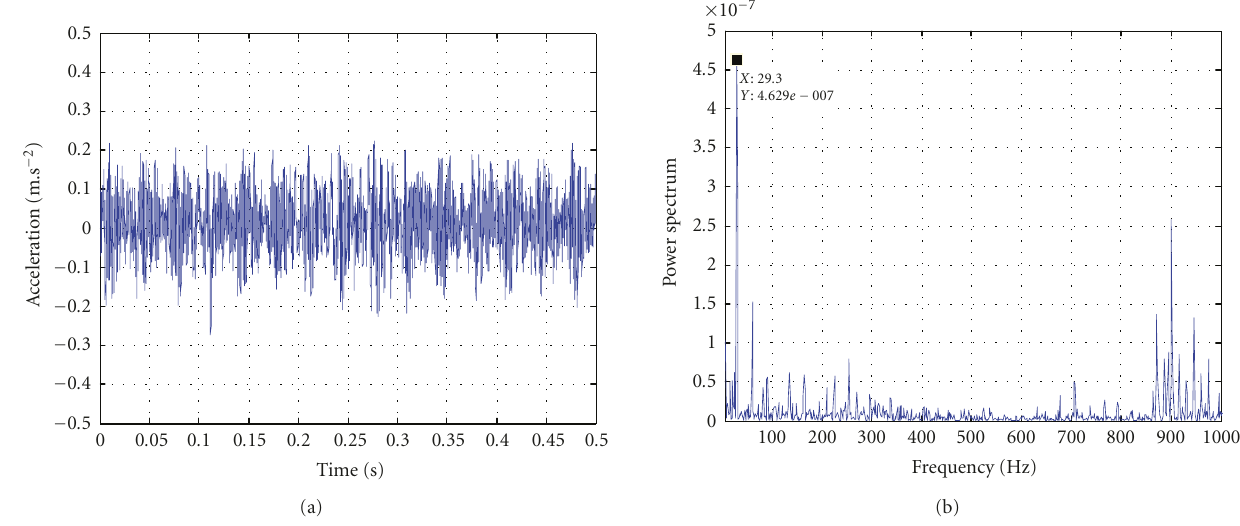
Figure 10: The vibration signal (a) and the corresponding TWPS (b) for new rolling bearing (CWRU data).